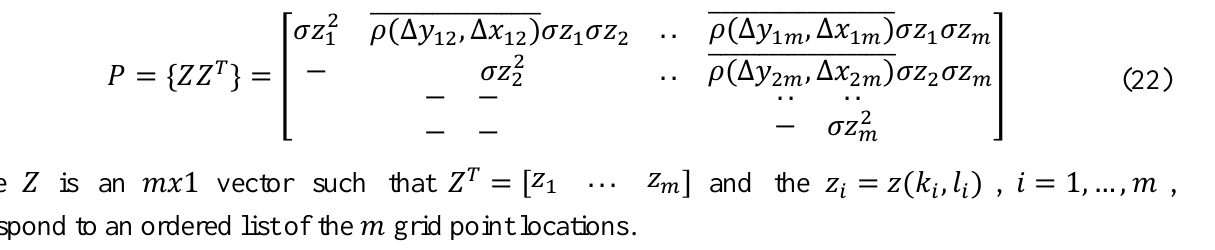
Figure 20. Non-homogeneous scalar realization—different variances.